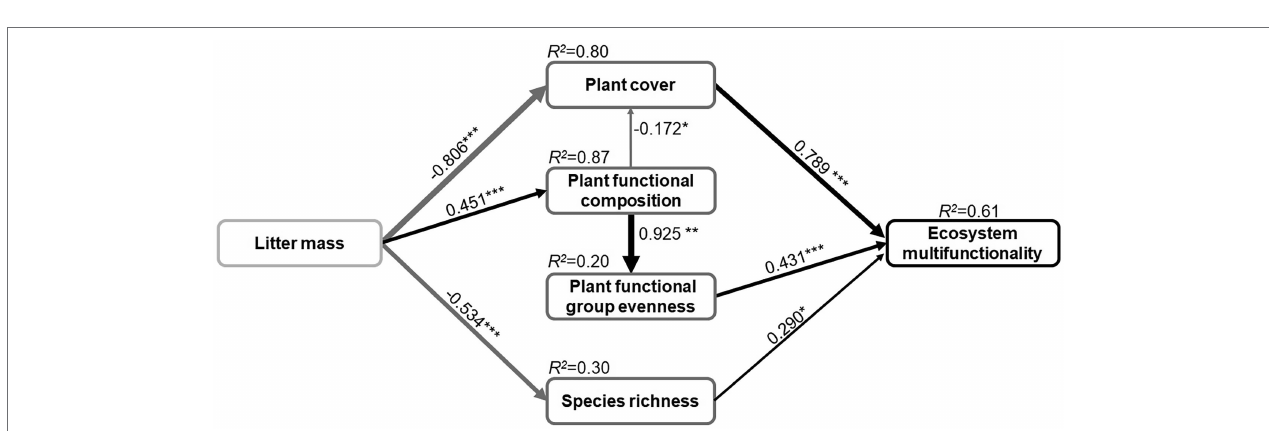
FIGURE 4 | The path analysis result of piecewise structural equation model showing the direct and indirect causal relationships of litter manipulation and plant community properties effects on ecosystem multifunctionality. The black and gray solid arrows indicate that the positive and negative effect is significant, respectively (* p < 0.05, ** p < 0.01, and *** p < 0.001). Arrow width and the associated number indicate the strength of the effect and the standard path coefficients, respectively. R 2 values represent the proportion of variance explained for each dependent variable. Fisher’s C = 14.82, value of p = 0.39, and AIC =